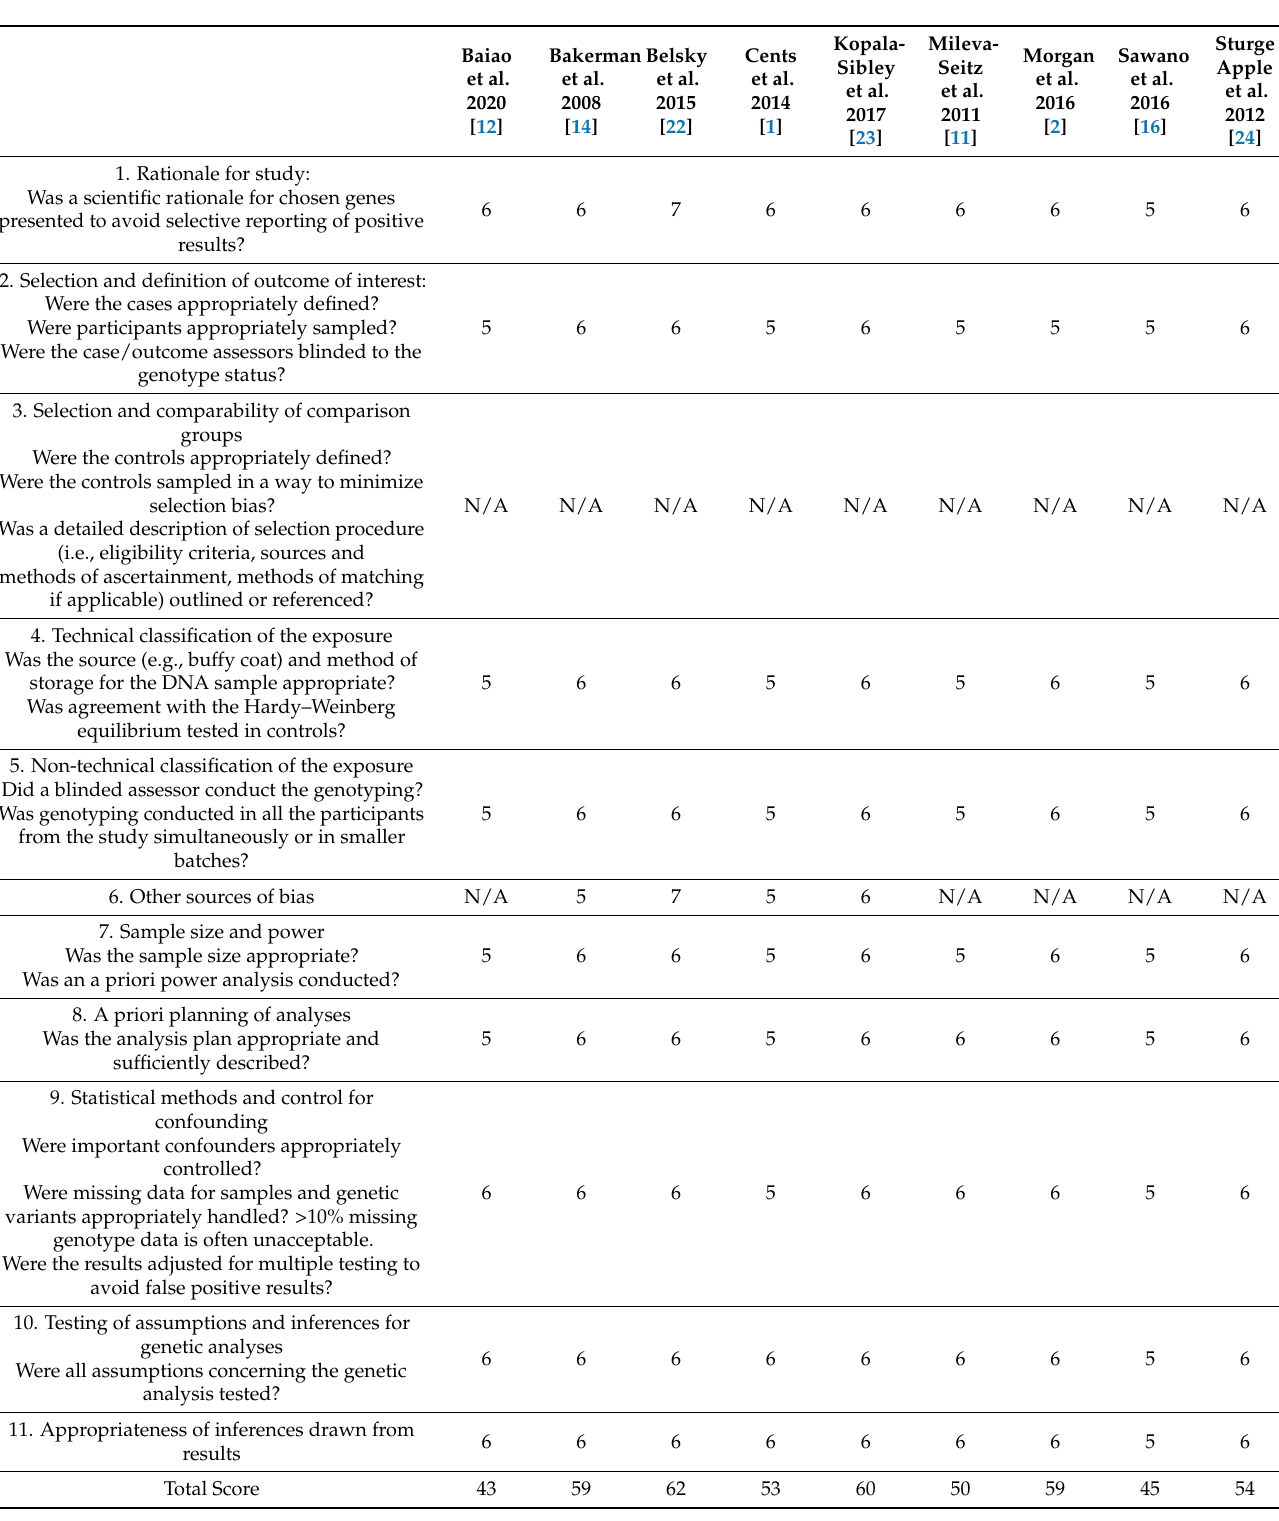
Table 1. Q-Genie